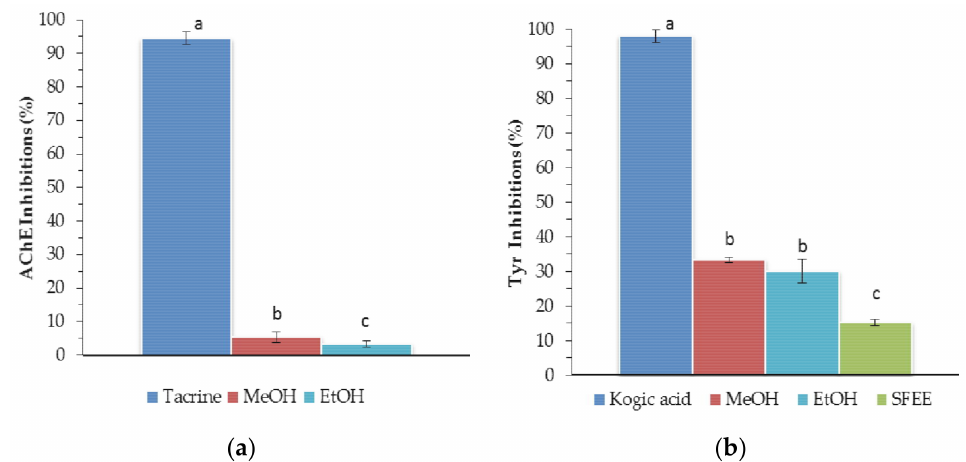
Figure 2. Acetylcholinesterase (AChE) and tyrosinase (Tyr) activity of basil extract from different extraction methods. Values with different letters were significantly different ( p ≤ 0.05) according to Tukey HSD and Scheff é tests. ( a ) AChE inhibition and ( b ) Tyr inhibition in basil